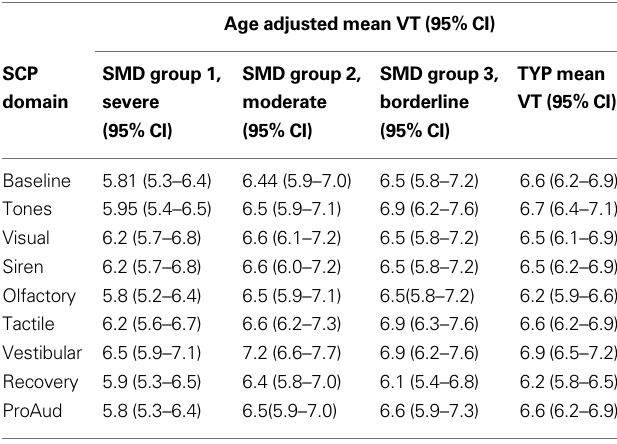
Table 4 | Differences in mean VT values for SMD classes versus TYP groups during